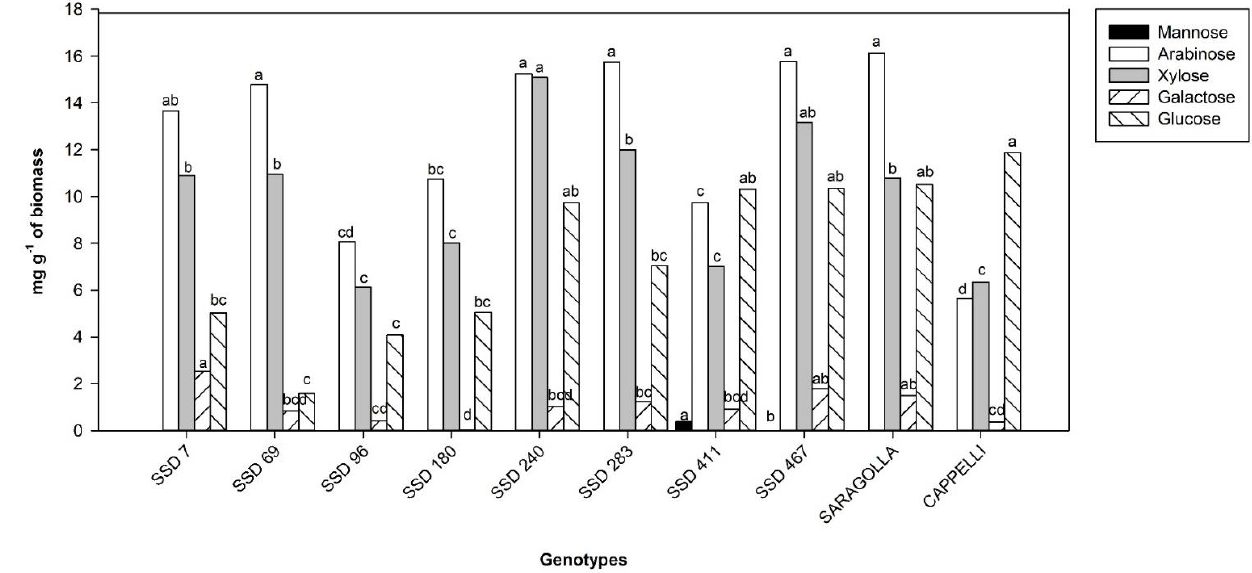
Figure 1. Hemicellulose amounts and composition. Results were expressed as mg g − 1 of biomass. Different lower-case letters, within the same column, indicate values significantly different according to Tukey’s multiple range test ( p < 0.05).